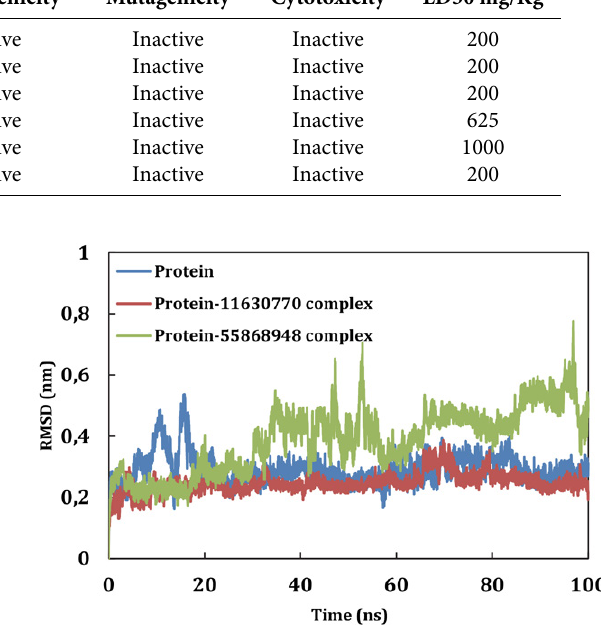
Fig. 7. Root mean square deviation (RMSD) of HIV-1 protease in the absence and presence of 11630770 and